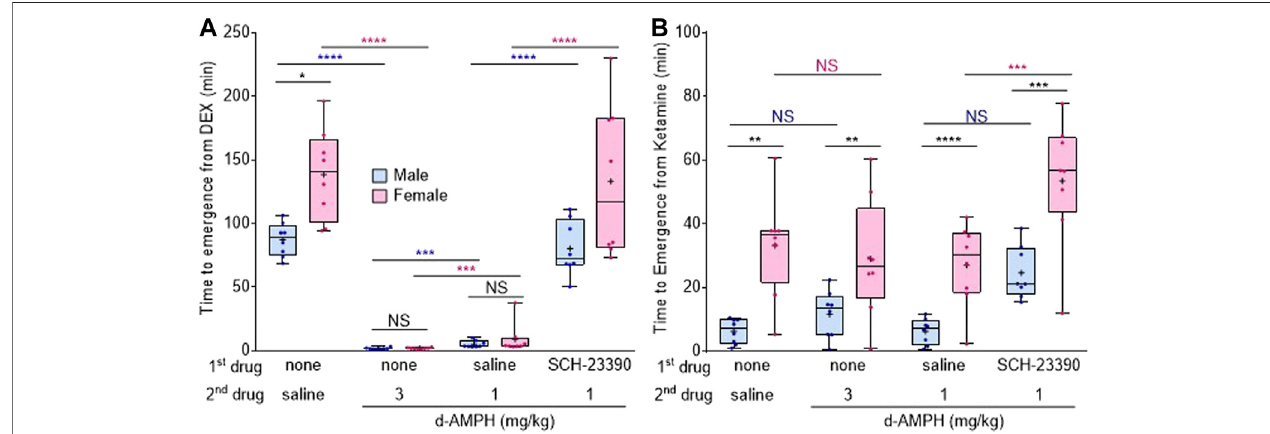
FIGURE 2 | Female rats are more sensitive to dexmedetomidine- and ketamine-induced unconsciousness than males. (A) Box-whisker plot of the time to emergence in male (blue) and female (magenta) rats after dexmedetomidine (50 μ g/kg), followed by the listed drugs (plus signs (cid:1) mean time to emergence, fi lled circle (cid:1) individual data point). (B) Box-whisker plot of the time to emergence after ketamine (50 mg/kg), followed by the listed drugs (* p < 0.05, ** p < 0.01, *** p < 0.001, **** p < 0.0001, Bonferroni post-hoc comparison; N.S. (cid:1) not signi fi cant; blue asterisk (cid:1) comparison between males, magenta asterisk (cid:1) comparison between females, black asterisk (cid:1) between male and female